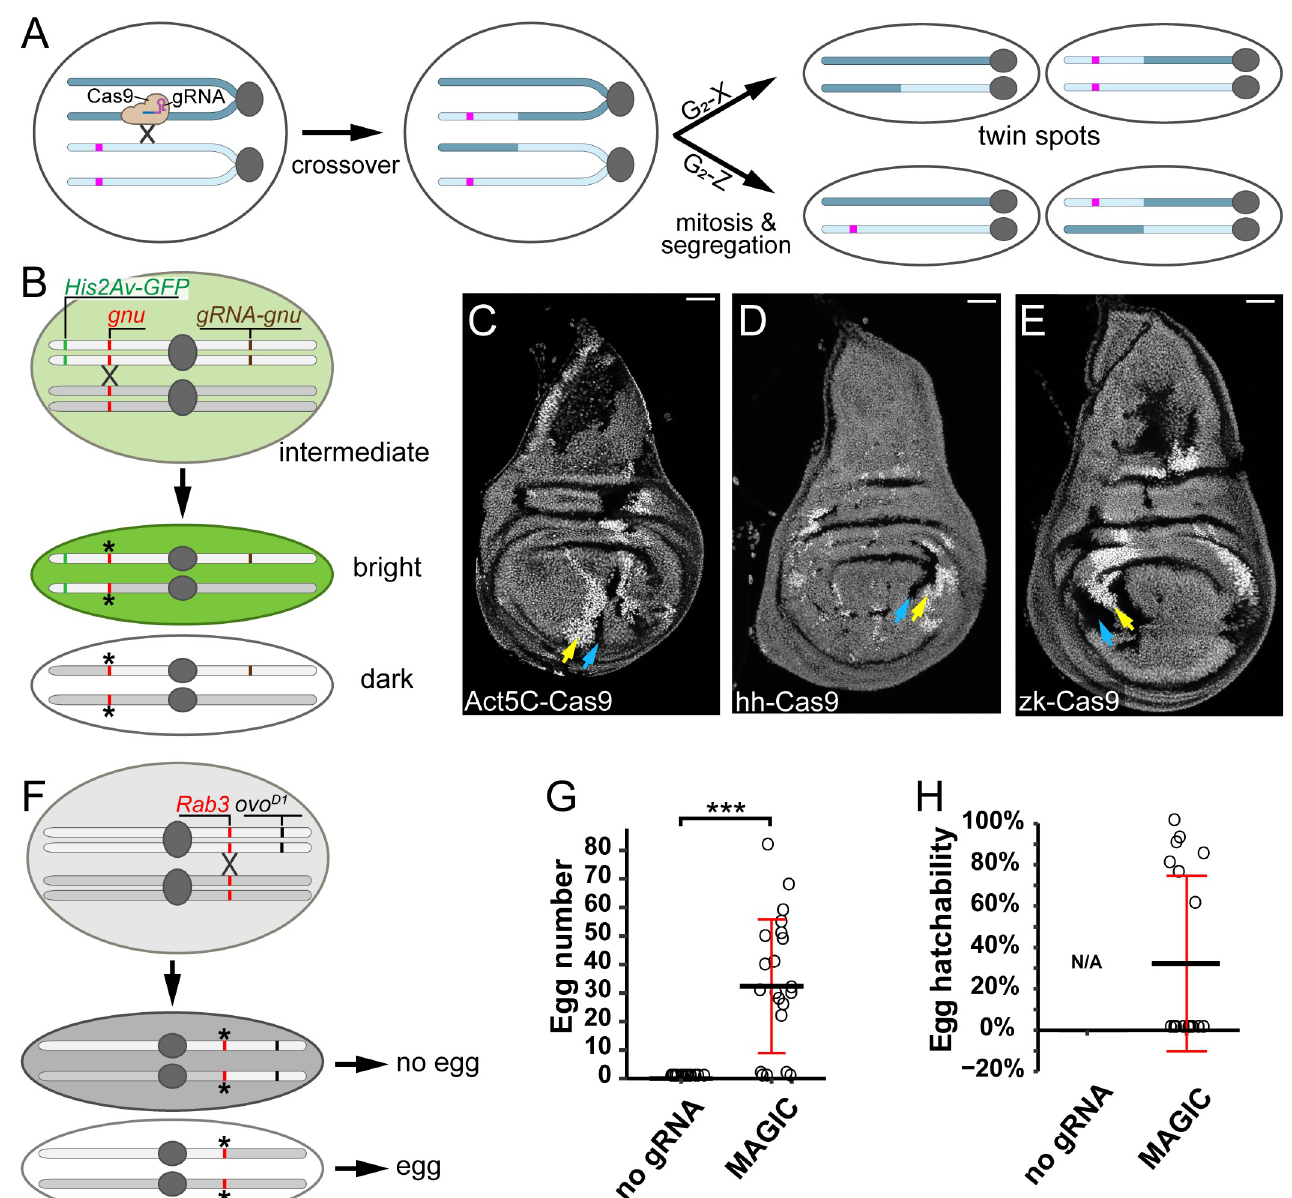
Fig 1. CRISPR-induced crossover generates somatic and germline clones in Drosophila . (A) A diagram illustrating the principle of MAGIC. The magenta bar indicates a marker that is lost from 1 daughter cell and becomes homozygous in the other in G 2 -X-generated twin spots. (B) Strategy for generating mosaic clones using the His2Av-GFP marker and a crossover at the gnu locus. Locations of the GFP marker (His2Av-GFP , green bar), the gRNA ( gnu-gR NA, brown bar), and the target of the gRNA ( gnu , red bar) are shown. Asterisks indicate mutated gRNA target sites. (C–E) Mosaic clones in wing discs visualized by levels of His2Av-GFP expression, as described in the text. A pair of arrows indicate His2Av-GFP +/+ (yellow) and His2Av-GFP − / − (blue) cells in each panel. Clones were induced by Act5C-Cas9 (C), hh-Cas9 (D), and zk-Cas9 (E). Scale bars, 50 μ m. (F) Strategy for generating and detecting clones in the female germline using ovo D1 . Figure labels are analogous to those in 1B; the gRNA is on another chromosome. (G) Number of eggs produced by females carrying nos-Cas9 and ovo D1 , with (MAGIC) or without (no gRNA) gRNA-Rab3 . ��� p < 0.001, Student t test. n = number females: no gRNA ( n = 18); MAGIC ( n = 18). (H) Hatchability of eggs produced females carrying nos-Cas9 and ovo D1 , with (MAGIC) or without (no gRNA) gRNA-Rab3 . n = number females: no gRNA (N/A); MAGIC ( n = 18). For quantifications in G and H, black bar, mean; red bar, SD. The data underlying this Figure can be found in S1 Data. GFP, green fluorescent protein; gRNA, guide RNA; MAGIC, mosaic analysis by gRNA-induced crossing-over.